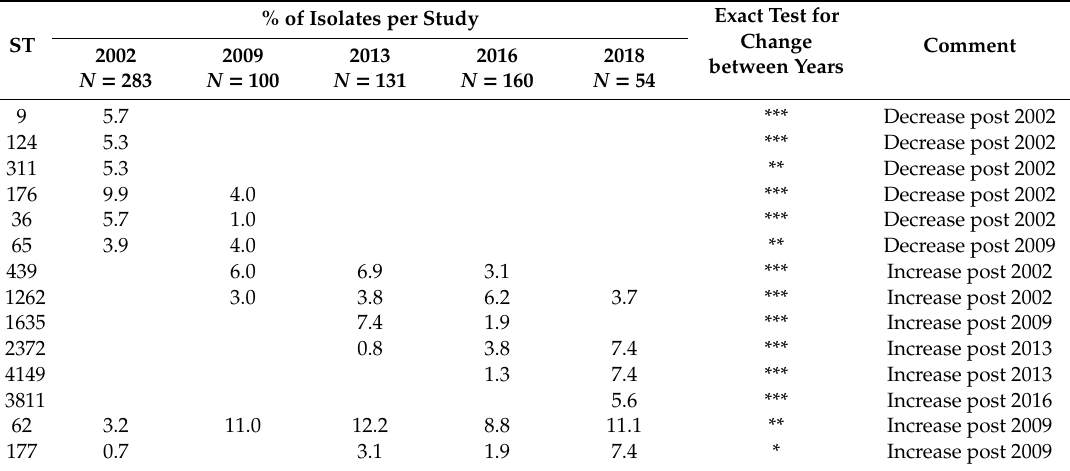
Table 4. Sequence types that showed significant increases or decreases over the time period (deduplicated